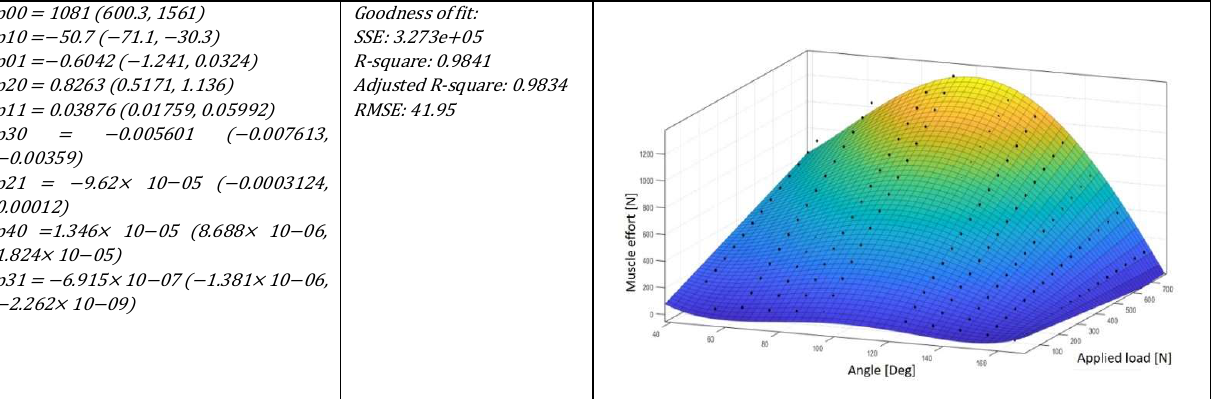
Figure 16. General formulation of long biceps efforts based on wrist load (W) and elbow angle ( α ) and surface reconstruction of the proposed polynomial.